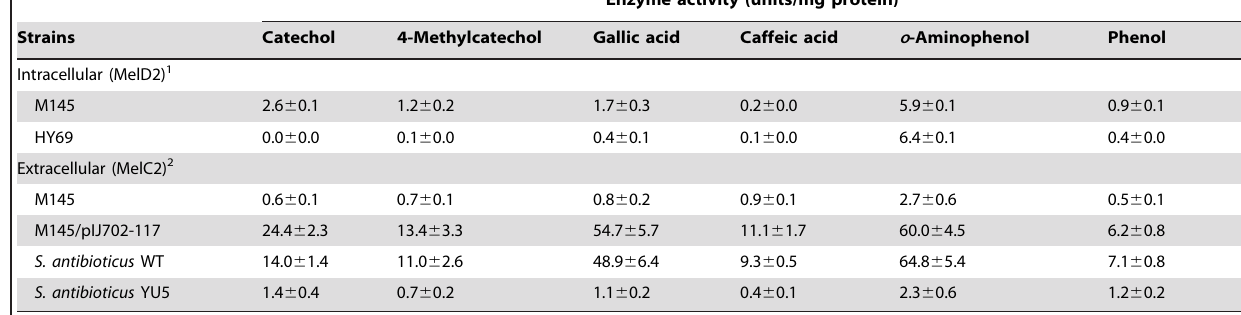
Table 1. Substrate specificity of MelC2 and MelD2.